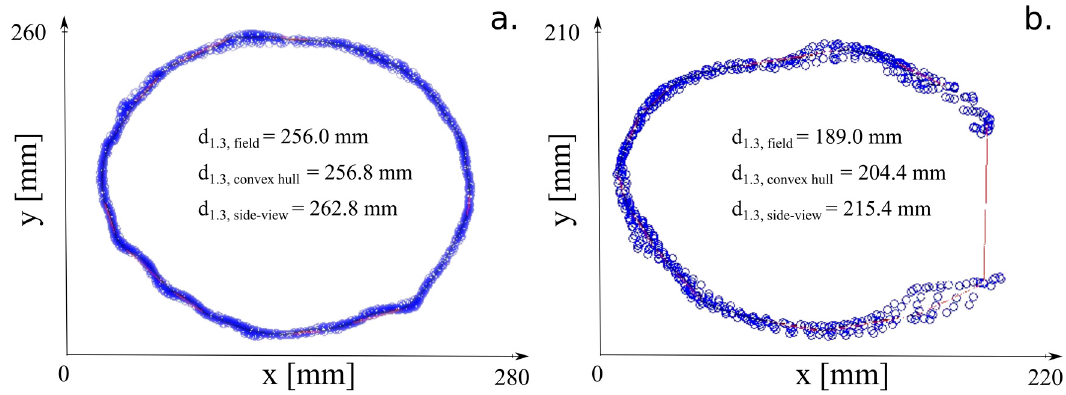
Figure 4. Diameter measurements on cross sections of the stem ( a ) successfully identified by the convex hull algorithm at height 4 m, ( b ) unsuccessful identified by the convex hull algorithm at height 11 m. The red line is the circumference of the tree as computed by the convex hull algorithm.